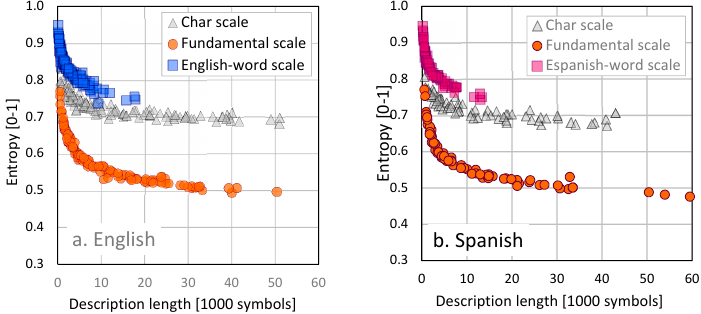
Figure 2. Entropy h vs. description length L in symbols. Graphs show the relationship between entropy h and scope L (symbol length) for descriptions expressed in: ( a ) English; ( b ) Spanish. The effect of the observation scale over the resulting observed entropy is shown for three observation scales: characters, words and the fundamental